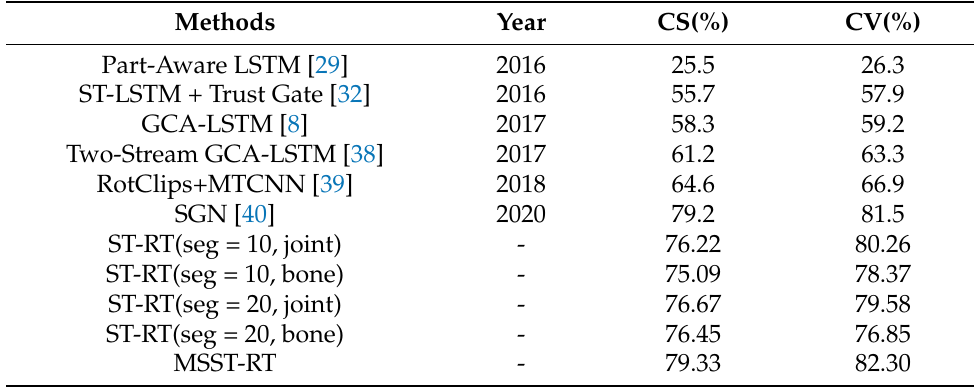
Table 2. Performance comparison for NTU RGB+D 120.